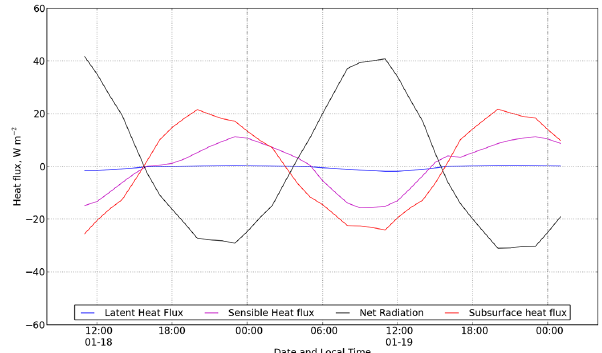
Figure 4. Simulated energy fluxes at the air–snow interface. Posi- tive atmospheric latent heat implies snow sublimation; positive sen- sible heat leads to transfer of energy from the snow to the atmo- sphere. Positive net radiation would be leading to heating of the snow surface. Positive subsurface heat flux means a transfer of en- ergy from the snow towards the atmosphere. Date is indicated in the lowest part of the x axis and local time just